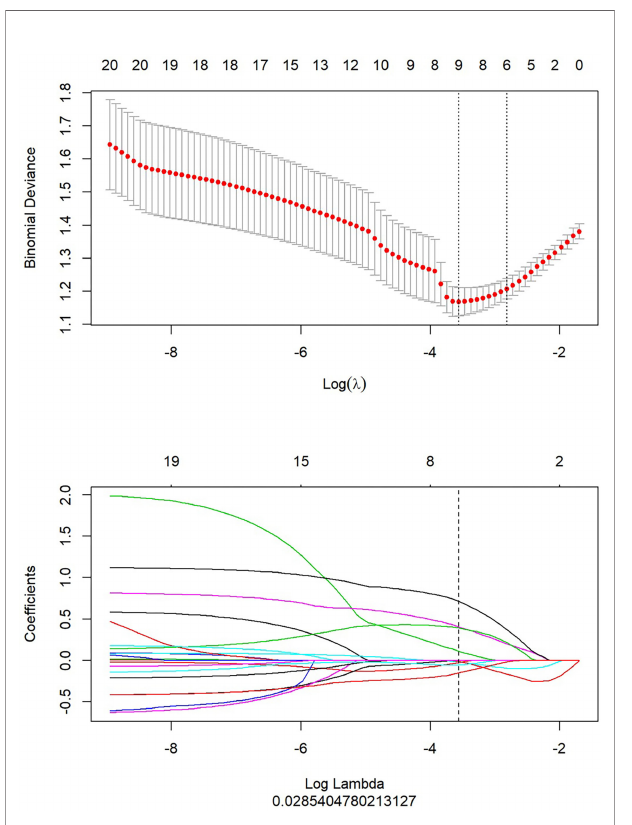
FIGURE 4 | After extraction of radiomics features, there were 9 optimal radiomics features left to constitute the LR-tumor/peritumor.